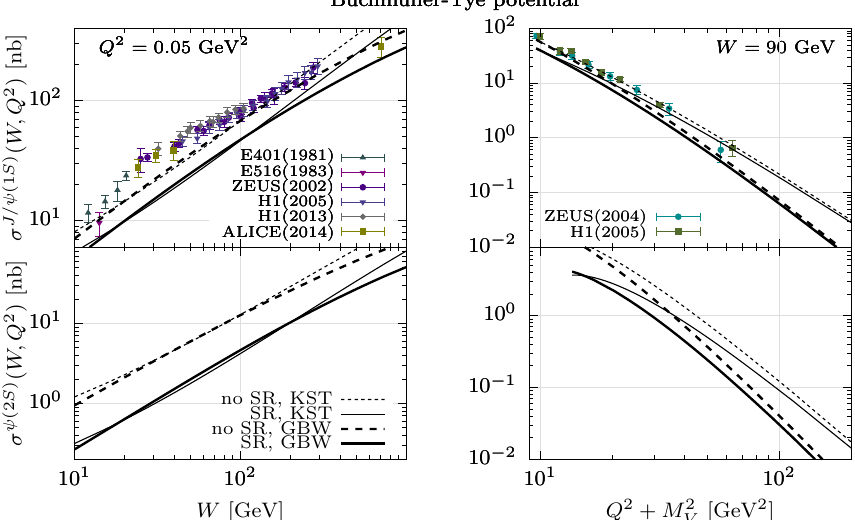
Fig. 1 Illustration of the impact of the Melosh spin rotation on the charmoniumelectroproductioncrosssectionsobtainedwiththephoton- like V → Q ¯ Q vertex operator. Left panels: Cross sections for γ p → J /ψ( 1 S ) p (left upper panel) and γ p → ψ (cid:4) ( 2 S ) p (left lower panel) processes with Q 2 = 0 . 05 GeV 2 as functions of γ p col- lision c.m. energy W (the experimental data are from Refs. [41–46]). Right panels: The same cross sections but as functions of the scale Q 2 + M 2 for the J /ψ( 1 S ) electroproduction (right upper box) and J /ψ